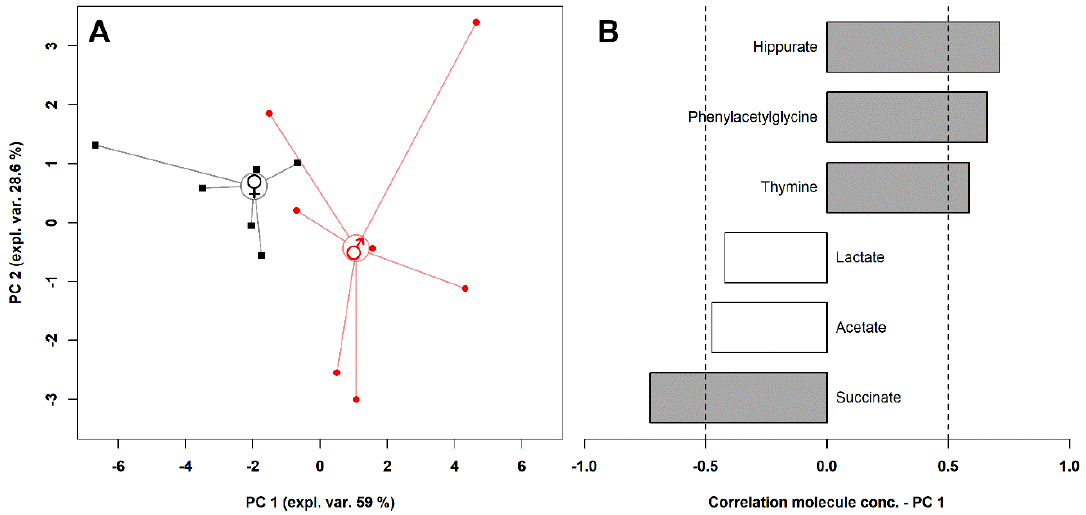
Figure 3. rPCA model calculated on the concentration of the significantly different molecules between male and female giraffes. The scoreplot ( A ) represents with squares and circles females and males, respectively. The median of each sample group is represented by wide circles. The loading plot ( B ) reports the correlation between the importance of each substance over principal component 1 and its concentration. Gray bars highlight significant correlations ( p < 0.05).